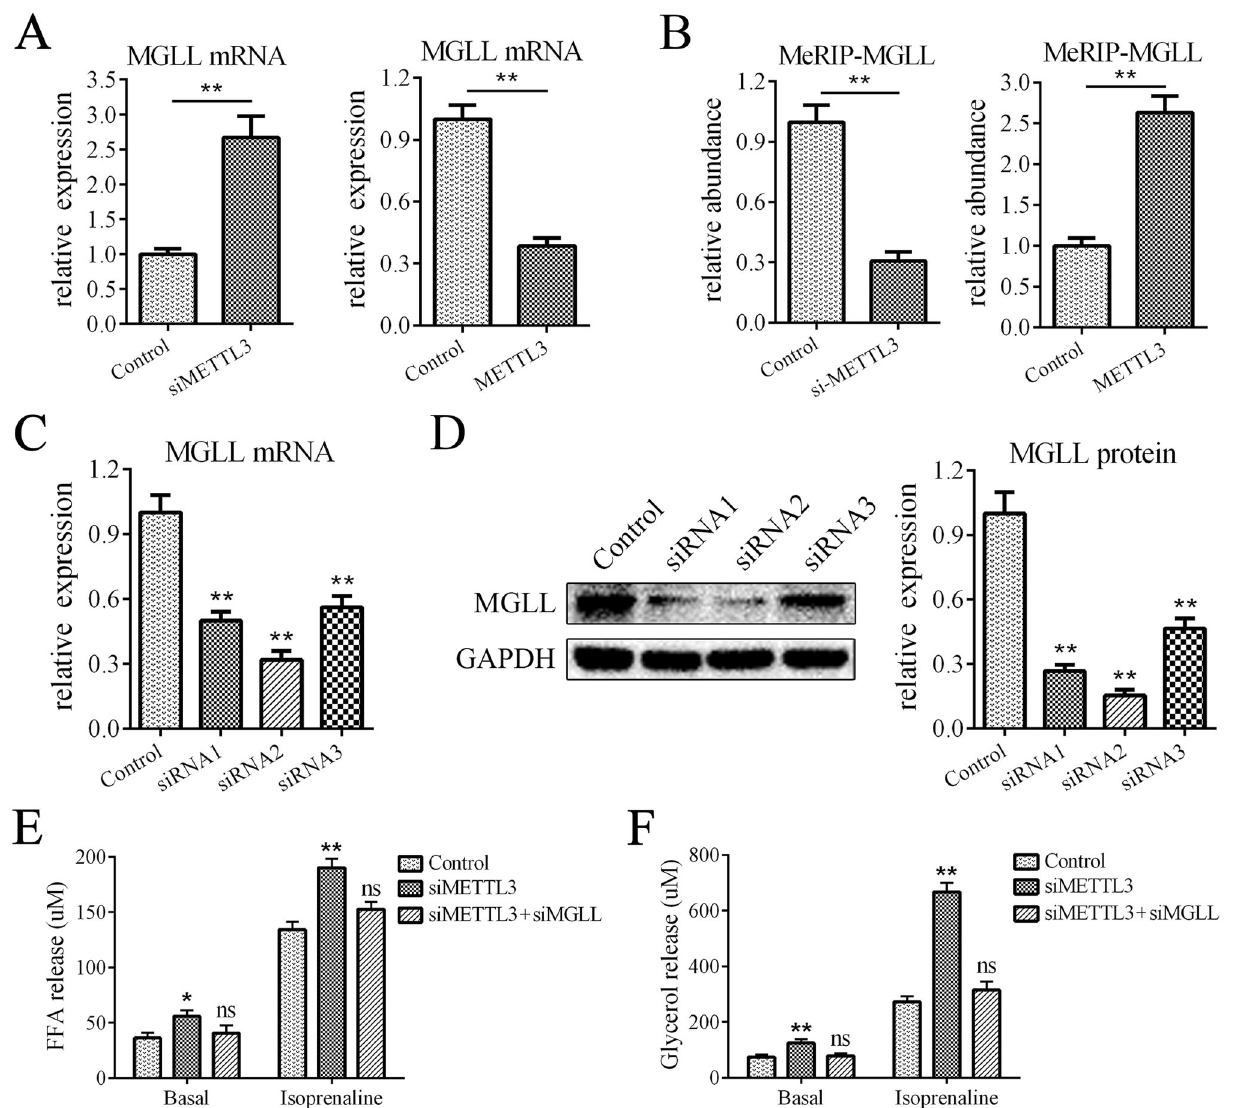
decreased by METTL3 downregulation and increased by METTL3 overexpression. C , D The mRNA and protein levels of MGLL in adipocytes transfected with siRNAs. E , F METTL3 downregulation increased the levels of FFA release and glycerol release and downregulation of MGLL rescued these effects; n = 9, * P < 0.05, ** P < 0.01, ns indicates not signi fi cant. Control means treatment of negative control siRNA in A (left), B (left), C - F and means treatment of negative control lentivirus in A (right), B